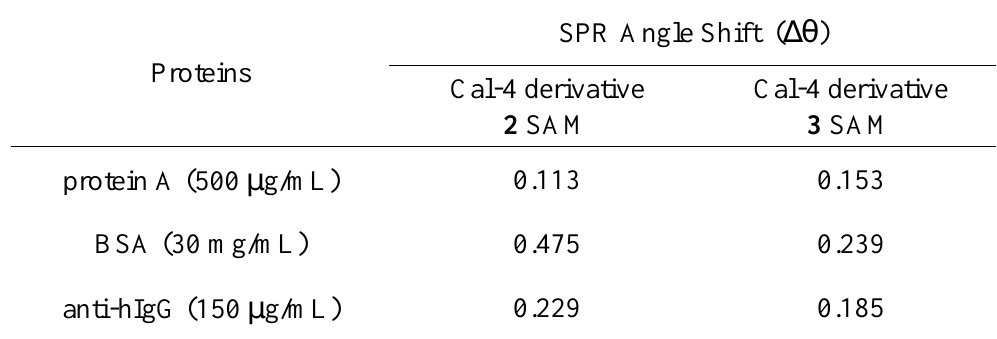
Figure 11 . Sensogram of probe protein immobilization on the Cal-4 derivative 3 SAM. Table 5 . SPR angle shifts according to the protein (protein A, anti-hIgG and BSA) immobilization on the Cal-4 derivative